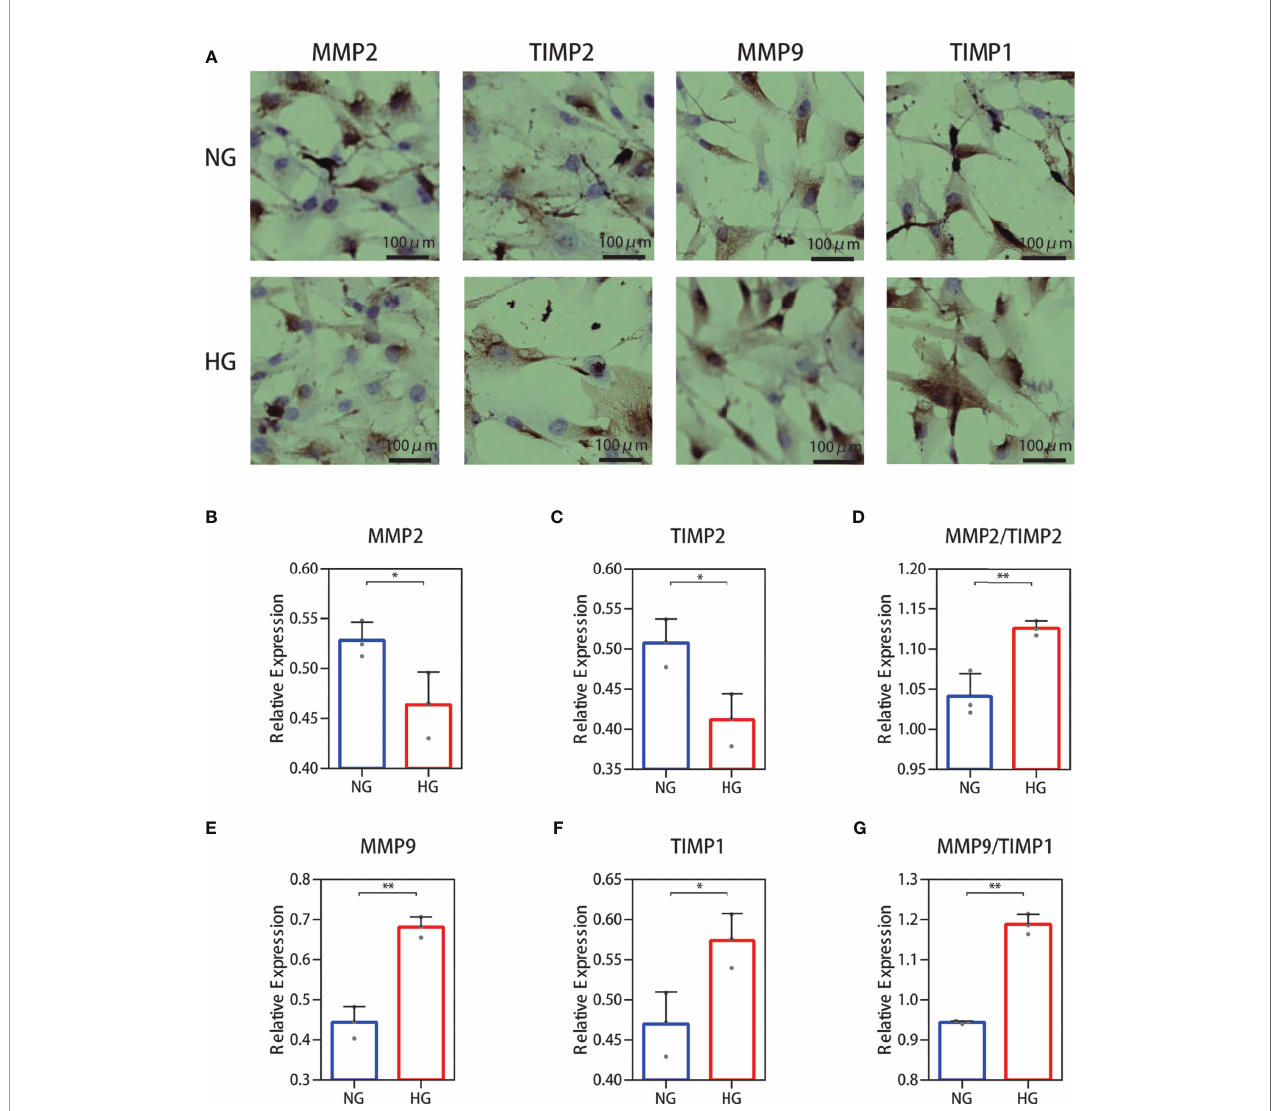
FIGURE 5 | Cell immunohistochemistry stain of the MMP-2/TIMP-2 and MMP-9/TIMP-1 ratio in high glucose-treated HDFs. (A) Representative cell staining of MMP- 2, TIMP-2, MMP-9, and TIMP-1 in HDFs. (B – D) Semiquantitative analysis of MMP-2, TIMP-2, and the ratio of MMP-2/TIMP-2. (E – G) Semiquantitative analysis of MMP-9, TIMP-1, and the ratio of MMP-9/TIMP-1. The independent experiment was repeated three times. The results are provided as the means ± SEM, * p < 0.05, ** p < 0.01 compared with the